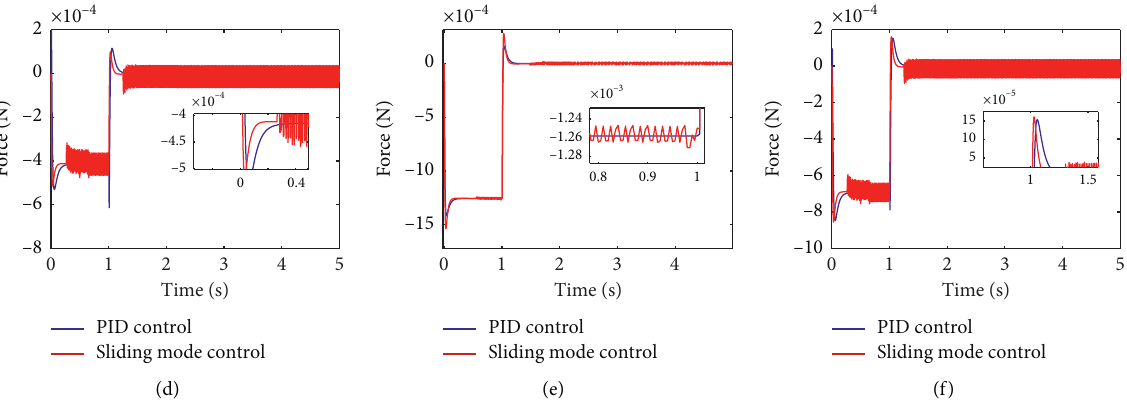
Figure 15: Comparison of PID control with slip mode control force input.